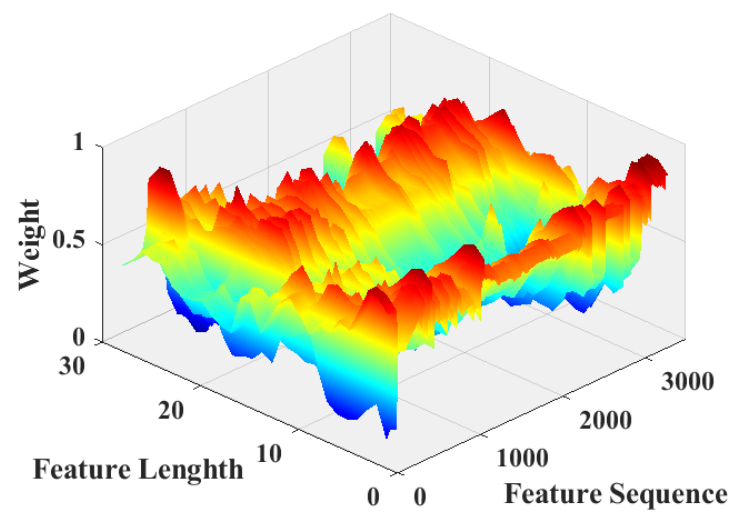
Figure 11. Weight of every spatial position of MSA.